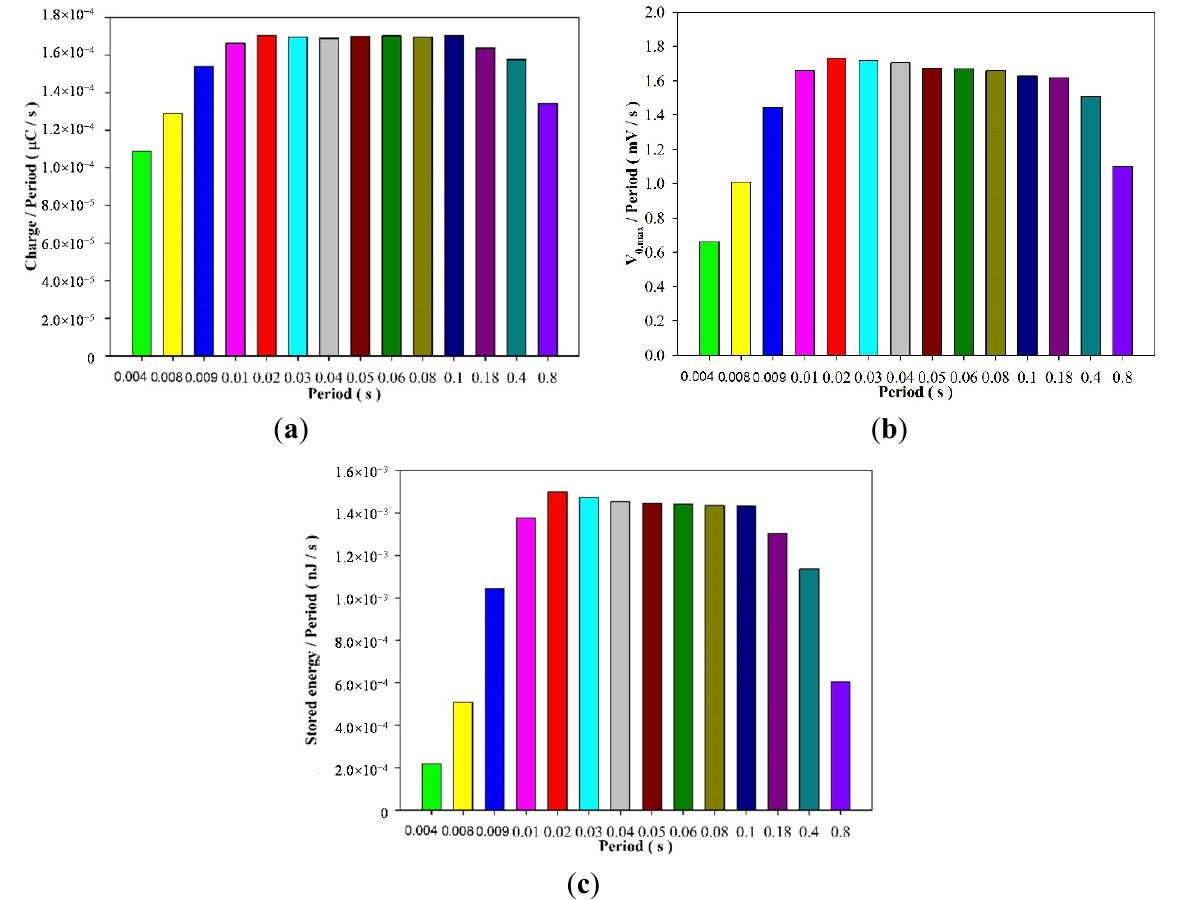
Figure 8. Relationships among ( a ) the induced charge per period; ( b ) the output voltage per period; ( c ) the stored energy per period and various periods for the 50 μ m thick PZT cell used for constructing the analysis